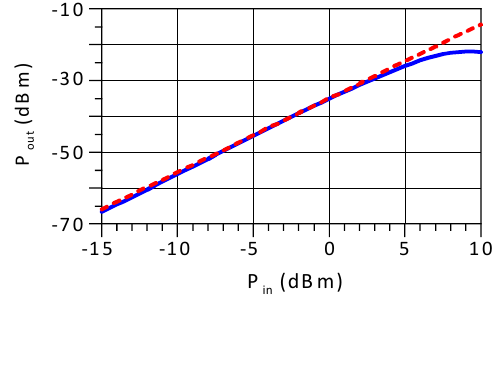
Figure 13: S-parameters ( fS )( ) of the designed NGD circuit shown in Figure 11. 22 dB